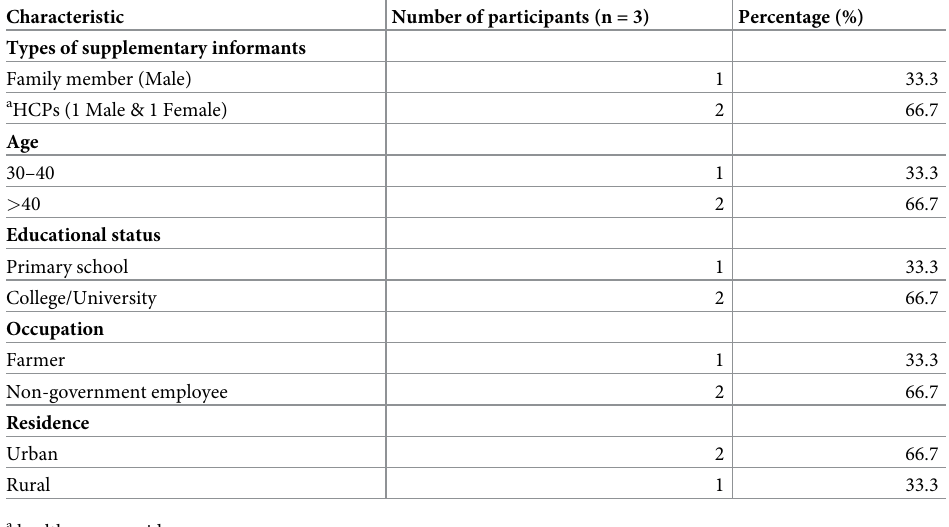
Table 2. Socio-demographic characteristics of key informants involved in an in-depth interview at Addis Ababa and Oromia Fistula centers, April to August 2019 (n = 3).